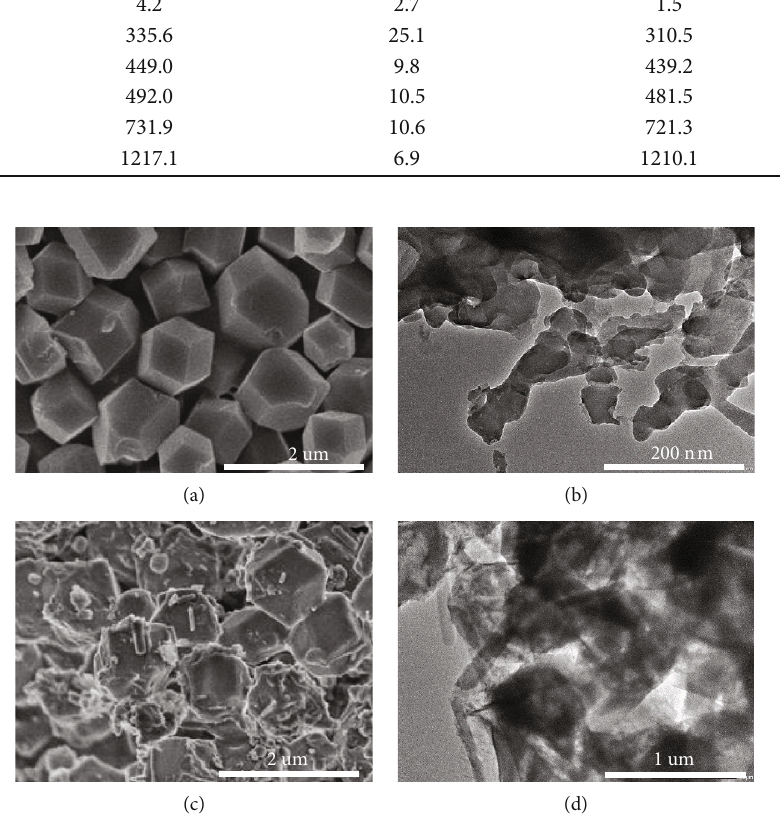
Figure 3: (a) SEM image of ZIF-67, (b) TEM image of g -C